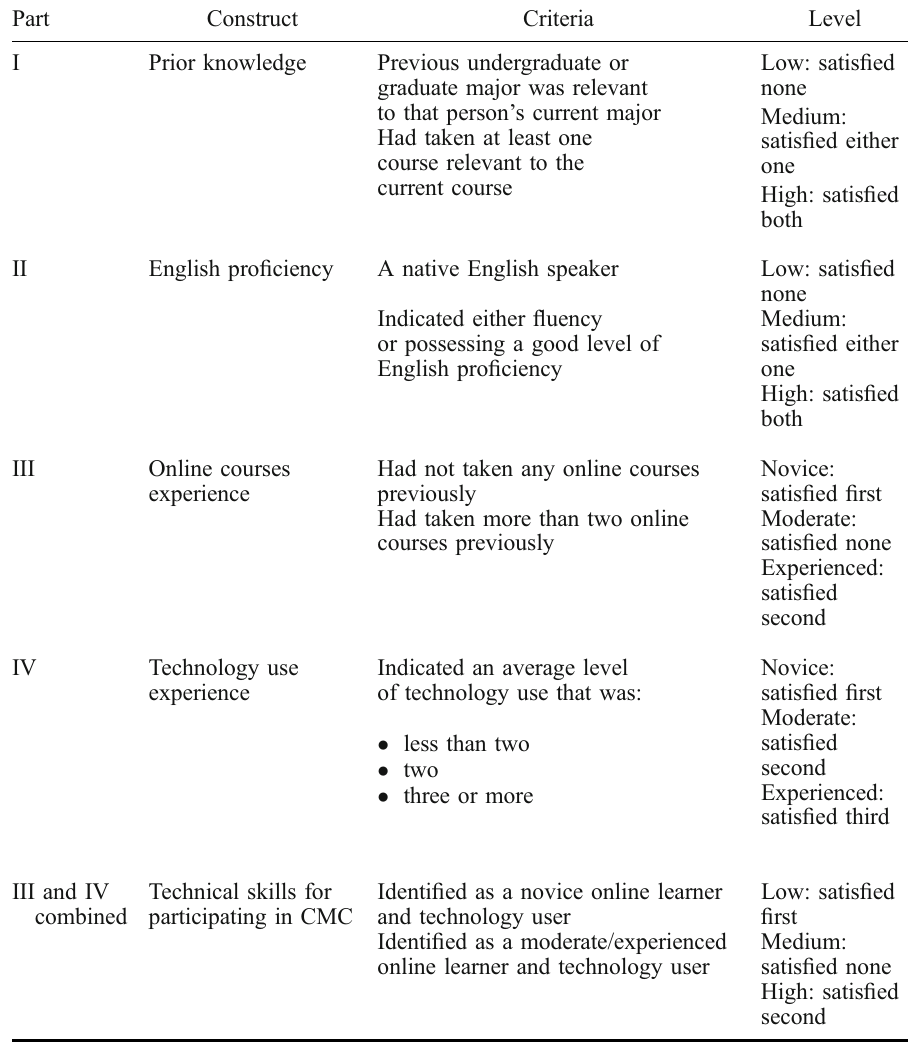
Table 2. Criteria to identify interviewees ’ level of background knowledge/skills.